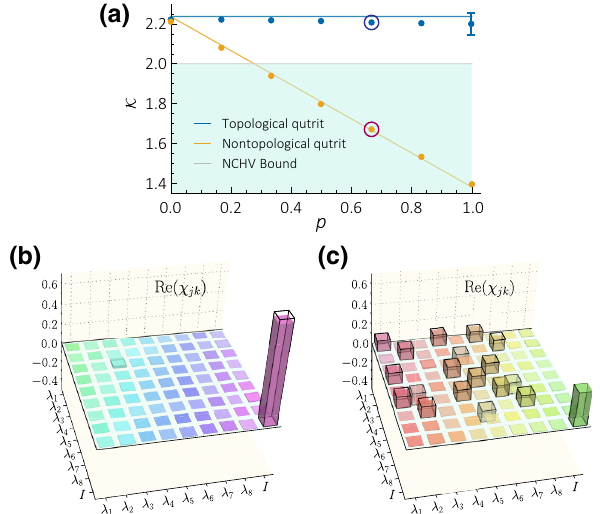
FIG. 6. The observation of topologically protected quantum contextuality. The local noise also reduces the violation of the KCBS inequality quantified by K , as shown in (a). However, the violation of a topologically protected parafermion qutrit, denoted by the blue line and points in both cases, is almost unaffected. The real parts of the process matrices, χ , of the noise operators spanned on the Gell-Mann basis at the circled data points are displayed in (b) for the parafermion qutrit and (c) for the nontopological qutrit. All elements in the imagi- nary part of the process matrices have absolute values of less than 1.25 × 10 − 2 . The edge and filling of the cuboids show the theoretical values and experimental results from quantum pro- cess tomography, respectively. The 1 σ error bars deduced from Poissonian counting statistics are too small to be visible on the